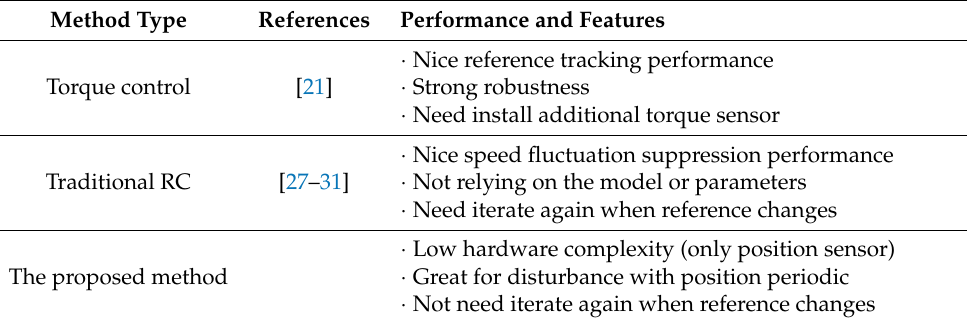
Table 1. Performance summary about kinematic error suppression